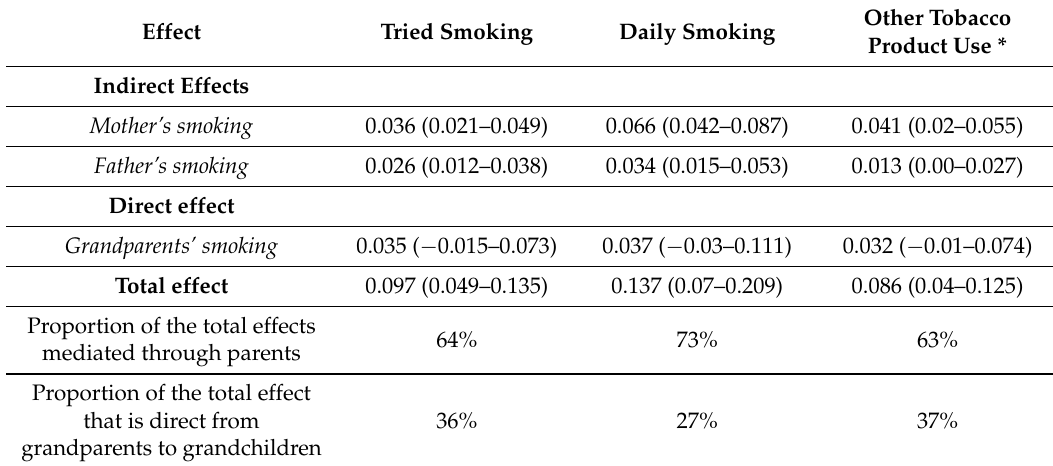
Table 5. Coefficients and their confidence intervals from mediation analysis of the association between grandparents’ smoking and grandchildren’s smoking experimentation, daily smoking and other tobacco product use * , considering mother’s and father’s smoking as